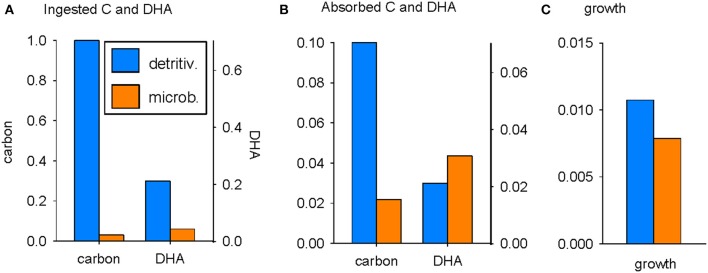
Utilization of C and DHA by zooplankton following the detritivorous (ψB = 0; blue) and microbial (ψB = 1; orange) pathways: (A) ingestion, (B) absorption, (C) growth. FD = 1 mol C m−3 d−1; units of ingestion and absorption of C, and growth, are mol C m−3 d−1; units for ingestion and absorption of DHA are mmol m−3 d−1. DHA is scaled to the optimum absorption ratio (Equation 10: see text).